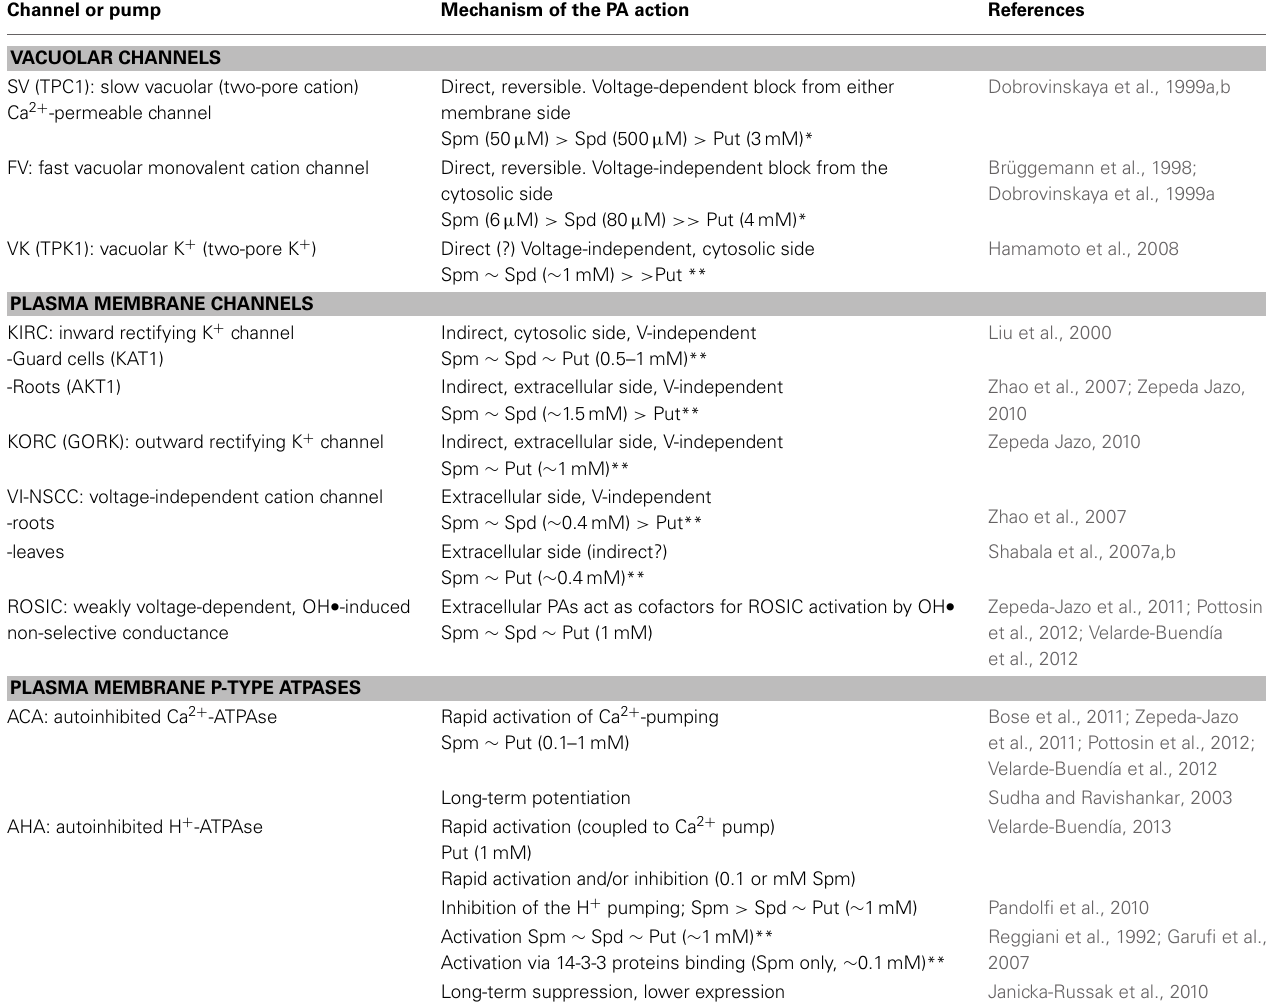
Table 3 | Summary of polyamine effects on plant ion channels and